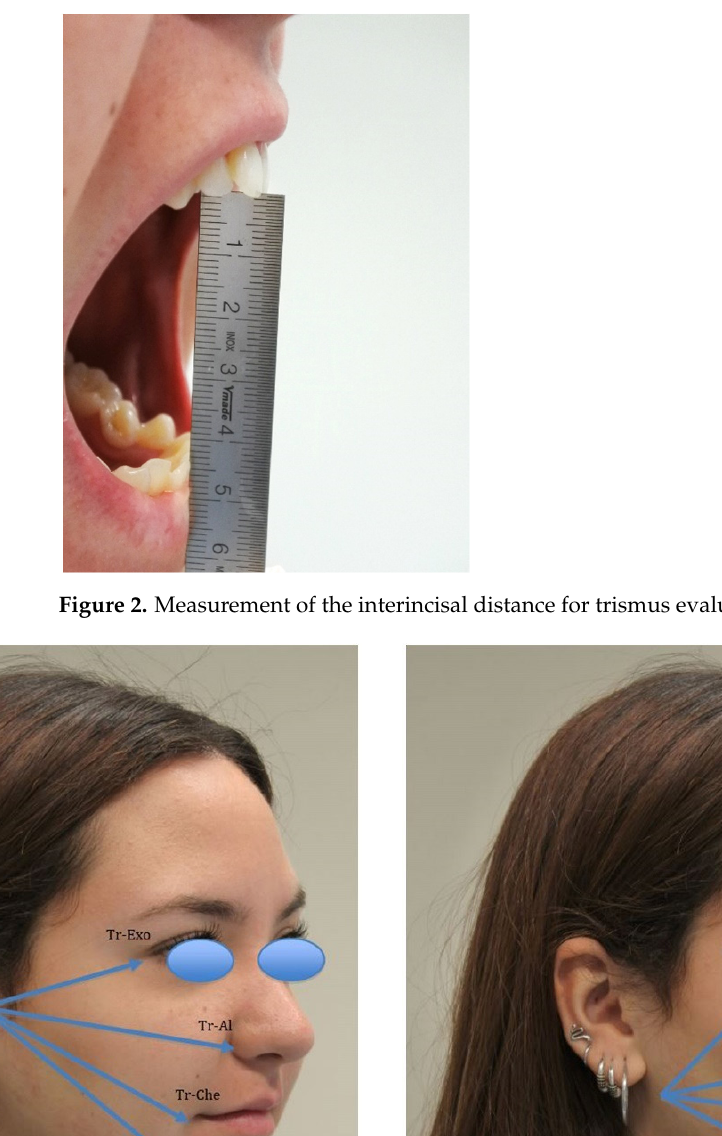
Figure 3. Facial and gnathological measurements for edema evaluation.